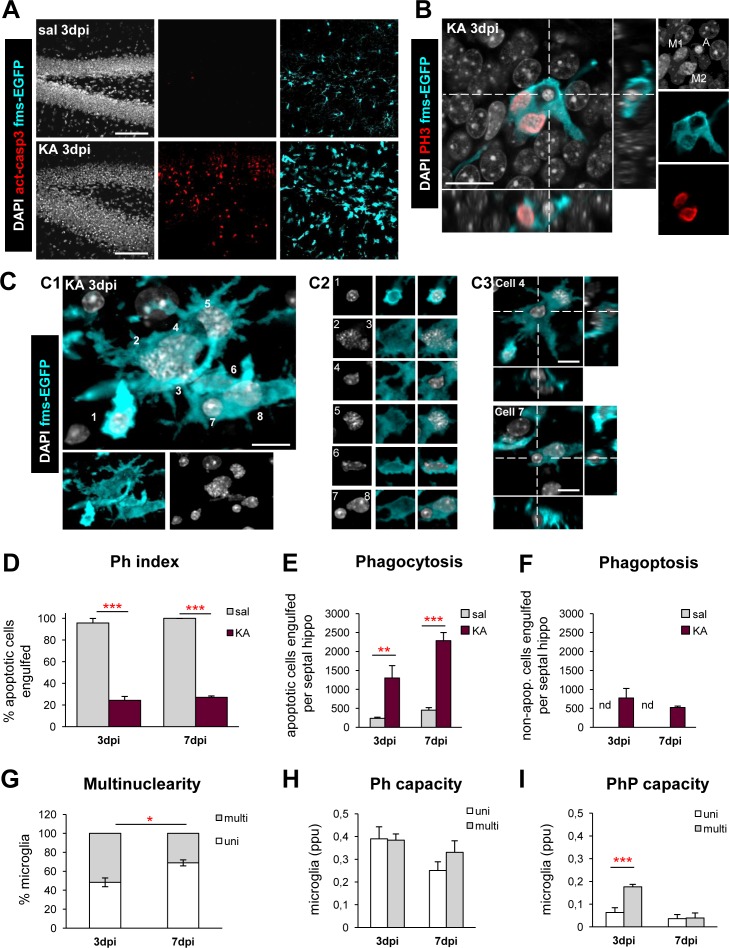
Partial recovery of microglial phagocytic efficiency at 3 and 7 dpi is accompanied by multinuclearity and phagoptosis.(A) Representative confocal z-stacks of saline and KA (3 dpi) hippocampi labeled with DAPI (nuclear morphology, white), activated caspase 3 (act-casp3+, red, for apoptotic cells), and fms-EGFP (cyan, microglia). At 3 dpi, KA led to an accumulation of apoptotic cells throughout the DG. (B) Orthogonal projection of a confocal z-stack from the hippocampus of a KA-treated mouse (3 dpi) showing a binucleated microglia cell (fms-EGFP+, cyan) undergoing division (phosphohistone 3, PH3, red) and phagocytosing an apoptotic cell (pyknotic by DAPI, white; A). Note the condensed chromosomes in the microglial nuclei, typical of mitosis (M1, M2). (C) Representative confocal z-stack of a large multinucleated phagoptotic microglia (fms-EGFP+, cyan) from the hippocampus of a KA mouse (3 dpi). Another example is shown in S4A Fig. (C1). 3-D-rendered image showing the continuum of EGFP through the microglial cytoplasm and within their nuclei. Up to eight nuclei were contained. (C2) Panel showing each nucleus individually. Nuclei 2, 3, and 5 showed condensed chromosomes, characteristic of an ongoing mitosis. Nuclei 4 and 7 were small but not pyknotic; they did not contain EGFP and thus were not microglial but rather surrounded by pouches of microglial cytoplasm. (C3) Orthogonal projections of nuclei 4 and 7 showing their complete engulfment by microglial processes (phagoptosis). (D) Ph index (in % of cells) in the septal hippocampus at 3 and 7 dpi (n = 3–7 per group). (E) Total number of phagocytosed apoptotic cells in the septal hippocampus after treatment with KA (3 and 7 dpi). (F) Total number of phagoptosed nonapoptotic cells in the septal hippocampus after treatment with KA (3 and 7 dpi). Nonphagoptosed cells were found in control animals. nd, not detected. (G) Proportion (in % of cells) between uni- and multinucleated microglia in the hippocampus of KA-treated mice at 3 and 7 dpi. (H) Weighted Ph capacity in the septal hippocampus after treatment with KA (3 and 7 dpi). (I) Weighted PhP (phagoptosis) capacity in the septal hippocampus after treatment with KA (3 and 7 dpi). Bars show mean ± SEM. * indicates p < 0.05, ** indicates p < 0.01, and *** indicates p < 0.001 by Student´s t test (G) or by Holm-Sidak posthoc test after two-way ANOVA (D, E) or one-way ANOVA (I) were significant at p < 0.05. Only significant effects are shown. Scale bars = 50 μm (A), 10 μm (B, C); z = 25 μm (A), 10.5 μm (C). Underlying data is shown in S1 Data.